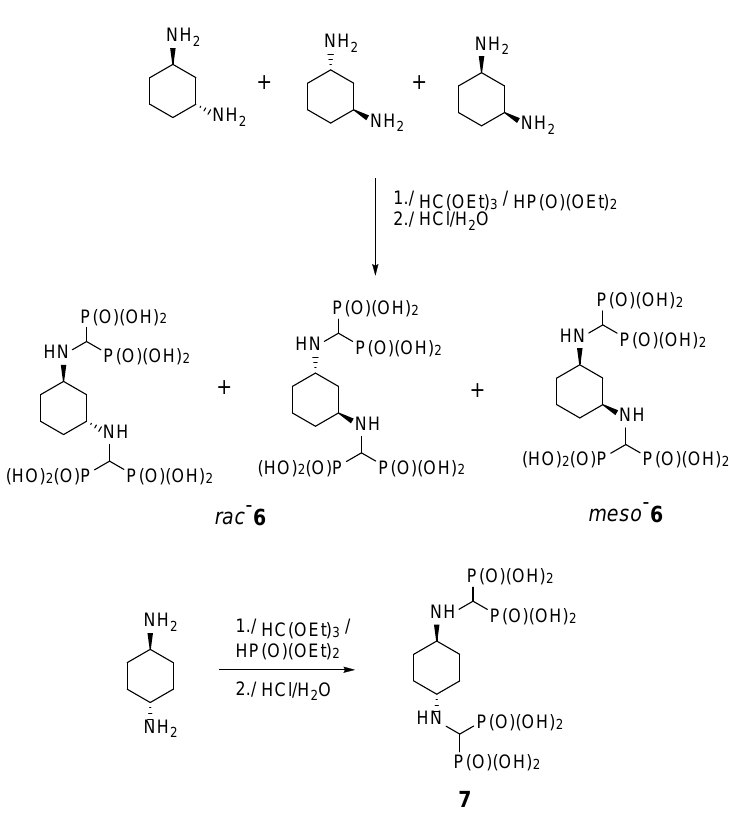
Figure 3. Products of the reactions of cyclohexane-1,3- and 1,4-diamines with triethyl orthoformate and diethyl phosphite.